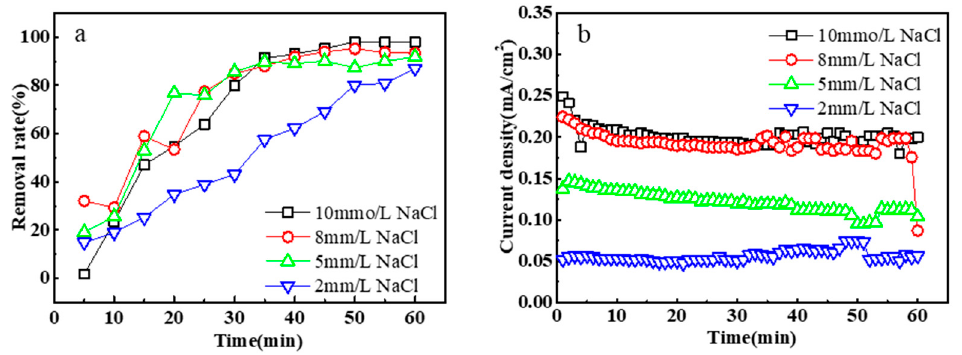
Figure 2. Effects of different electrolyte concentrations on ( a ) phosphate removal and ( b ) current generation in the aluminum–air fuel cell.